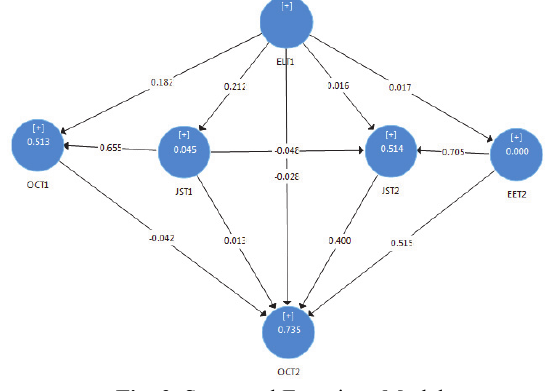
Fig. 3. Structural Equations